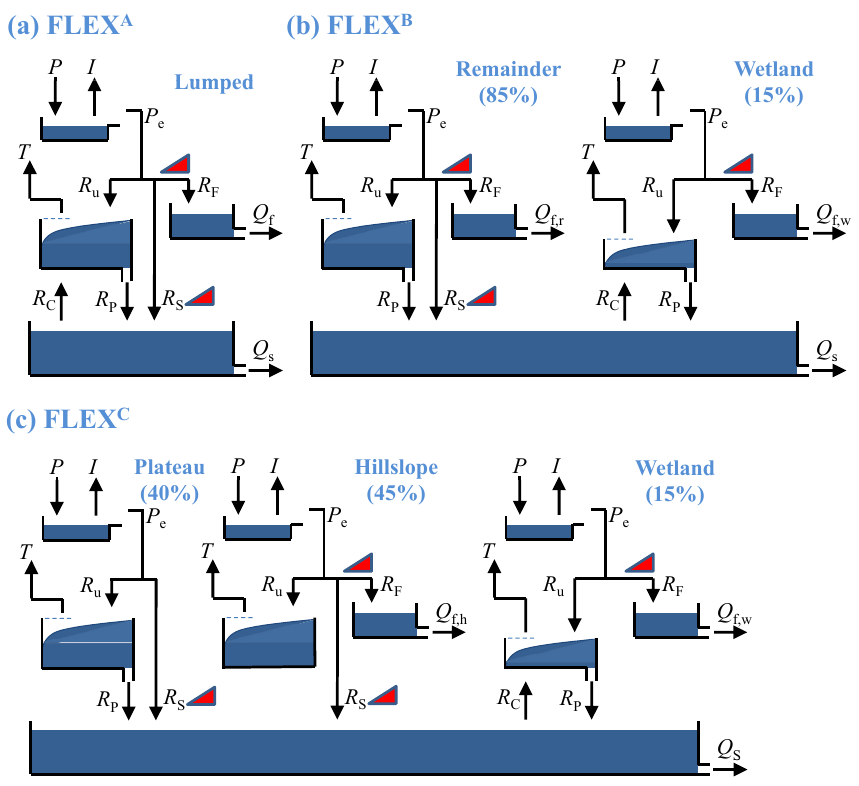
Figure 2. The model structures for (a) FLEX A , (b) FLEX B and (c) FLEX C